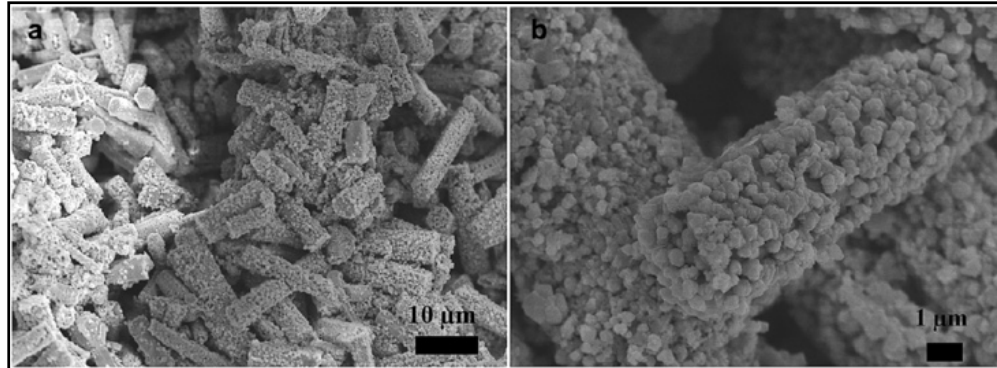
Figure 17. FE-SEM images of the CuO/ZnO nanorods at different magnifications. Reproduced with permission from reference [134].